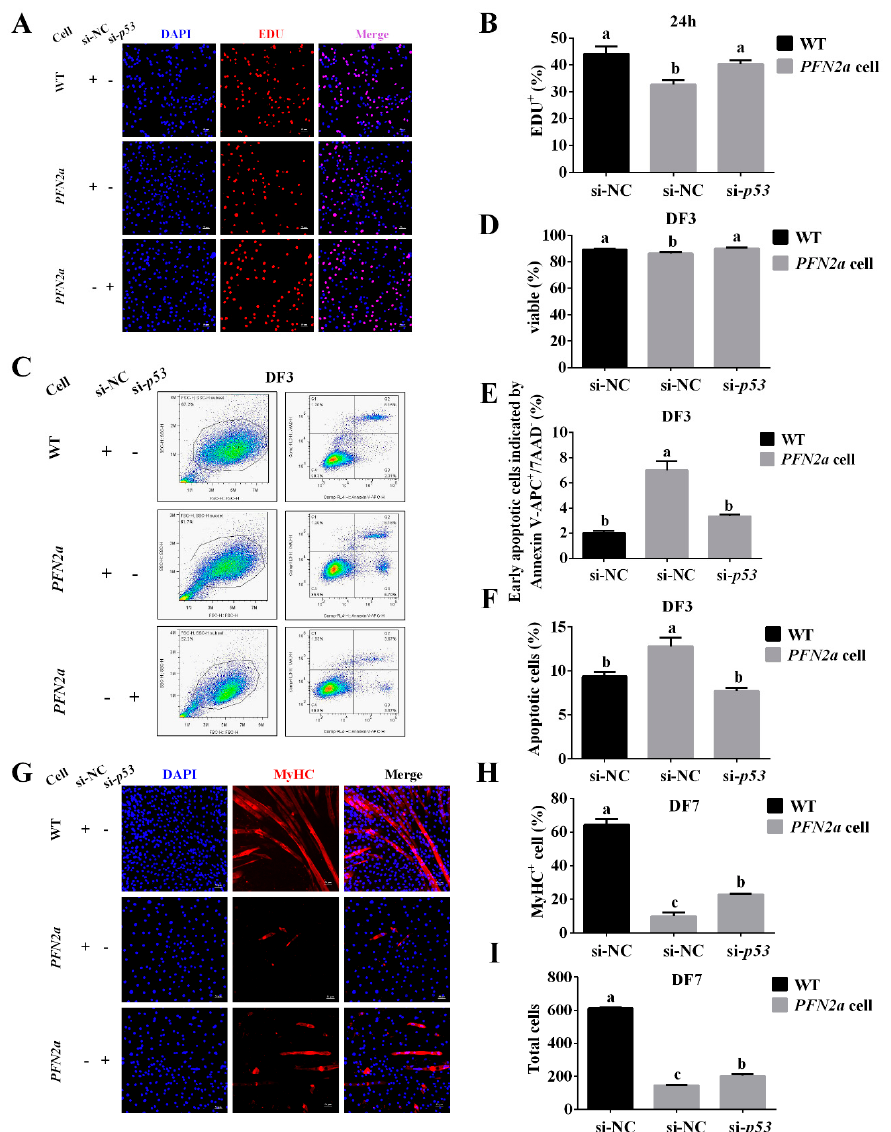
Figure 6. PFN2a overexpression suppressed myogenic development through p53. ( A ) Representative images of the EDU staining for proliferating WT and PFN2a cells are shown. ( B ) EDU labeling analysis of the function of si- p53 in abolishing the PFN2a effect on C2C12 proliferation. ( C ) Cell apoptosis assay analysis of the function of si- p53 in attenuating the PFN2a promotion effect on C2C12 apoptosis at the stage of differentiation. ( D ) si- p53 increased the number of viable cells in comparison with PFN2a cells. ( E ) si- p53 decreased early apoptotic cells compared with PFN2a cells. ( F ) si- p53 decreased the total number of apoptotic cells compared with PFN2a -overexpressing cells on differentiation day 3. ( G ) Representative images of the MyHC immunofluorescent staining for differentiated WT and PFN2a cells on differentiation day 7. ( H ) Anti-MyHC immunofluorescent assay showed the si- p53 effect on PFN2a expression to inhibit C2C12 differentiation on differentiation day 7. PFN2a decreased the percentage of MyHC-positive cells. ( I ) The total number of cells in magnification 200 × on di ff erentiation day 7. The results were presented as mean ± S.E.M. of triplicate experiments for each group. The data are in a normal distribution; and homogeneity of data between each treatment group is equal by SPSS analysis. Significant di ff erences between treatment groups were determined by one-way ANOVA (SPSS v18.0, IBM Knowledge Center, Chicago, IL, USA). p < 0.05 was considered statistically significant. WT: wild type C2C12 cells; PFN2a cell: PFN2a -overexpressing C2C12 cells; 24h: on proliferation day 1; DF: di ff erentiation; Si-NC: siRNA-negative control; Si- p53 : siRNA- p53